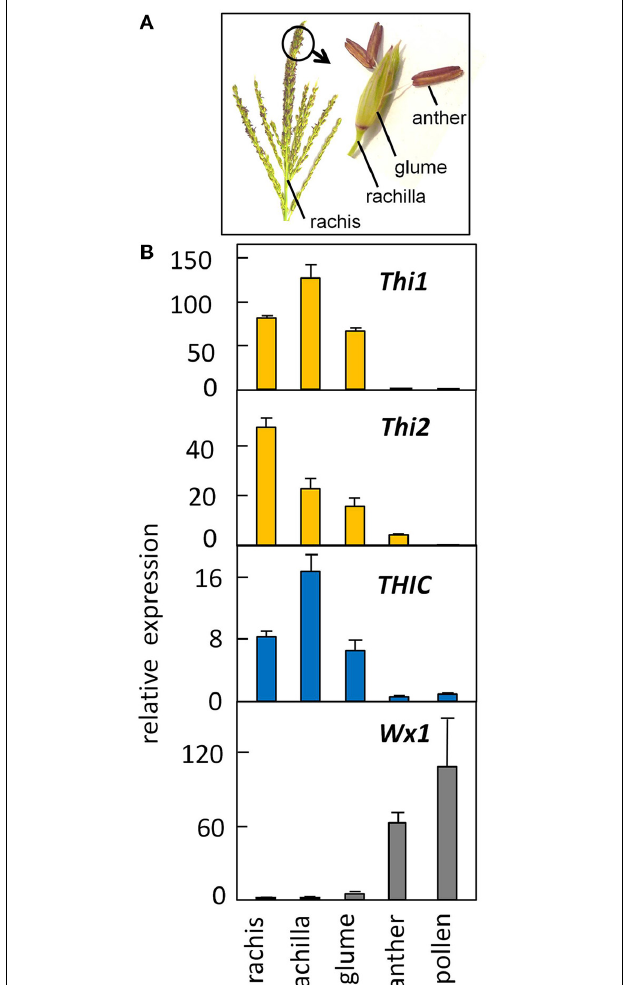
FIGURE 5 | Low expression of the thiamine biosynthetic pathway in developing pollen contrasts with high expression in surrounding floral organs. (A) Structure of the male inflorescence of maize (image, J. Saunders; art, K. E. Koch). (B) Gene expression in floral organs and developing pollen. RNA was quantified by qRT-PCR (see Methods). Late-binucleate stage pollen was isolated from developmentally staged anthers as described by Wen and Chase (1999). The Wx1 starch synthase was measured as a positive control for pollen gene expression. Error bars are standard error of the mean, n = 3.